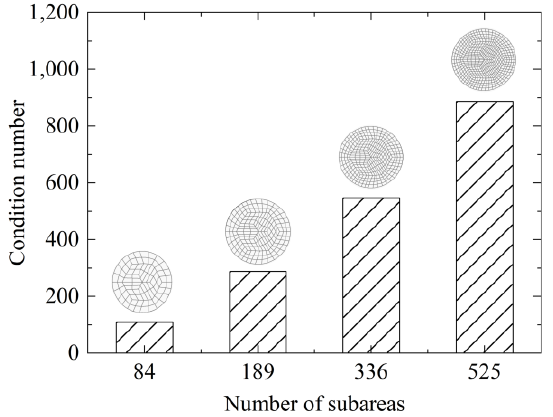
Figure 8. Condition number changes of matrix A versus number of subareas.